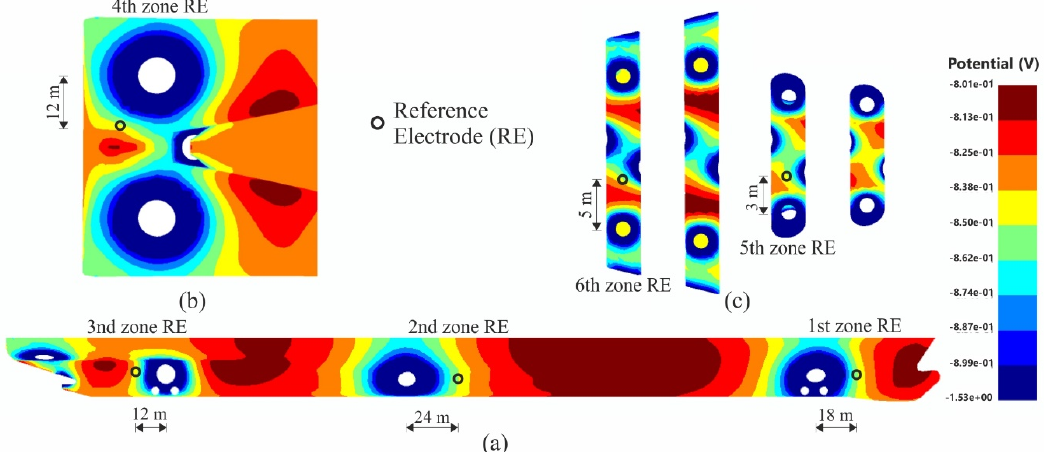
Figure 15. Reference electrode (RE) locations for each zone; ( a ) first, second, and third zones; ( b ) fourth zone, and ( c ) fifth and sixth zones.